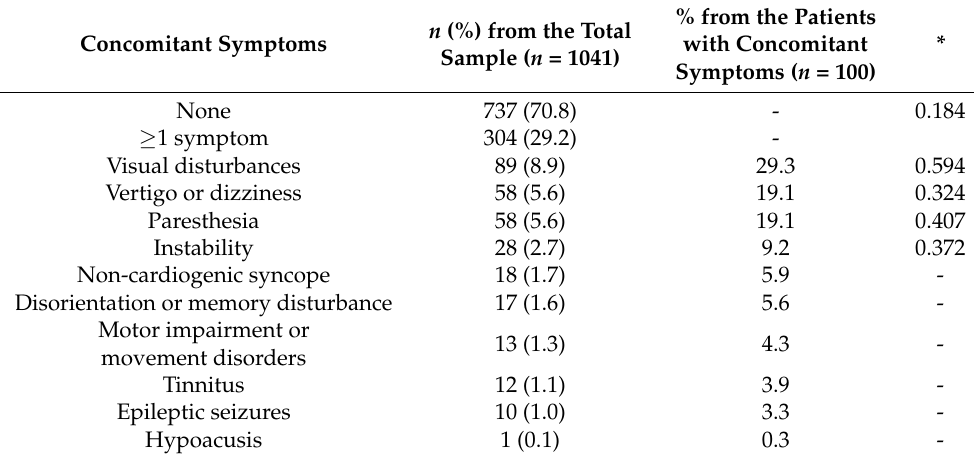
Table 3. Concomitant symptoms reported by the patients who required magnetic resonance imaging due to headache.